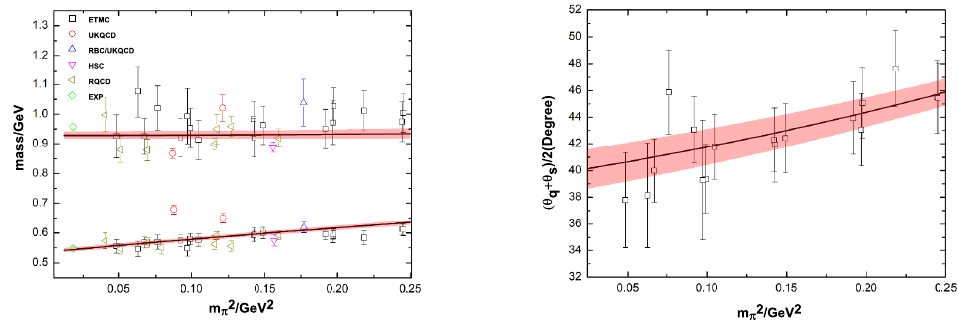
Figure 1 . The masses of η and η 0 as functions of m π (left panel) and the pion-mass dependences of the η – η 0 mixing angle in the quark-flavor basis (right panel). The lattice data of the η/η 0 masses are taken from ETMC [53], UKQCD [54], RBC/UKQCD [55], HSC [56] and RQCD [57]. For the η/η 0 masses from ref. [57], only the results from the ensemble with approximately physical mass of strange quark are included. The lattice data of mixing angles in the quark-flavor base are taken from ref.